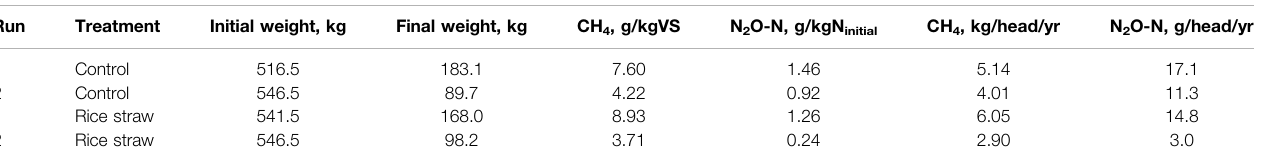
TABLE 2 | Summary of the GHG emission during beef manure